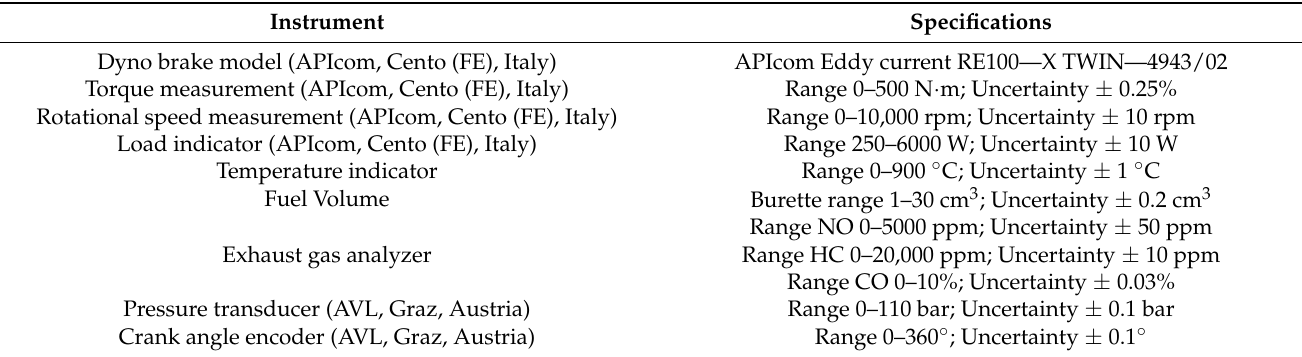
Table 3. Main specifications about the measuring instruments used in the test